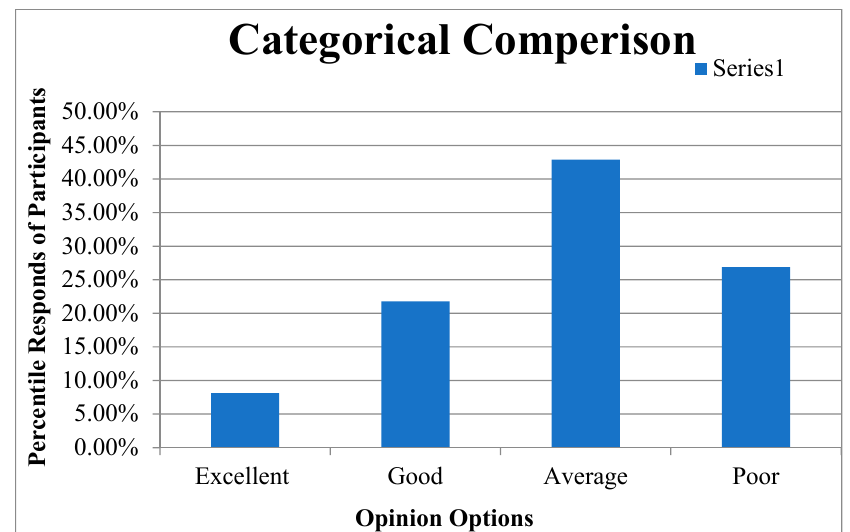
Figure 4. Categorical comparison. Table 7. Group III based on Questions